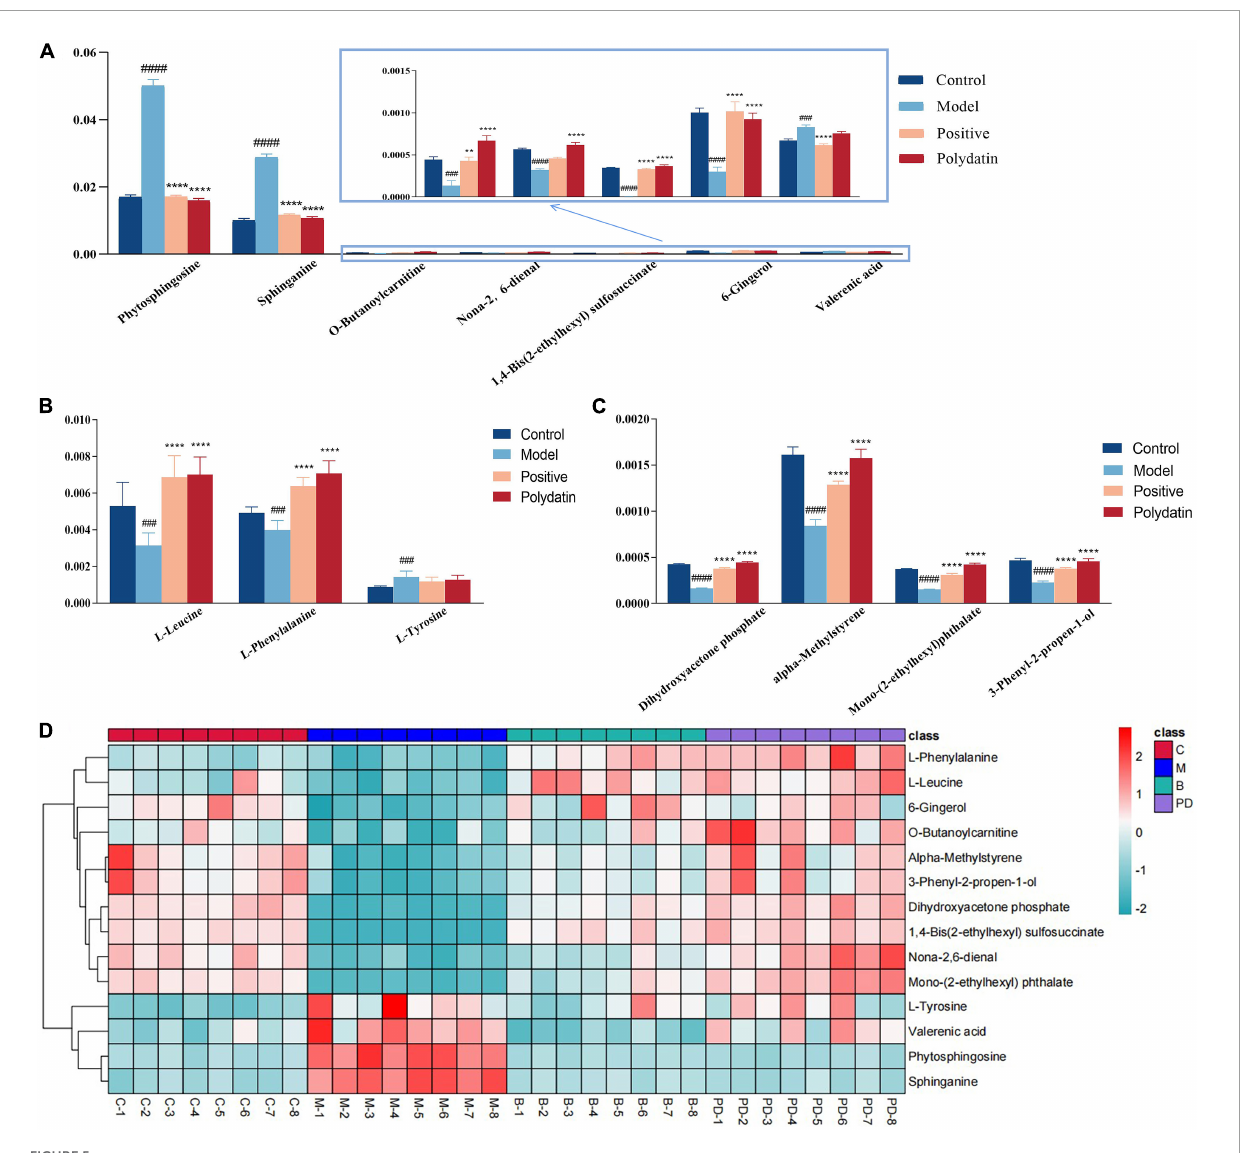
FIGURE5 The relative levels of differential metabolites in serum from control group, model group, positive group and polydatin group. Comparison of signal intensity of significant metabolites related with lipid metabolism (A) , amino acid metabolism (B) and other metabolism (C) in different groups (D) . The hierarchical clustering heatmap of differential metabolites in serum from different groups. Deeper red represents up-regulation and deeper blue represents down-regulation, and each cell stands for one metabolite ( ∗∗ p < 0.01, ∗∗∗∗ p < 0.0001, vs. model group; ### p < 0.001, #### p < 0.0001, vs. control